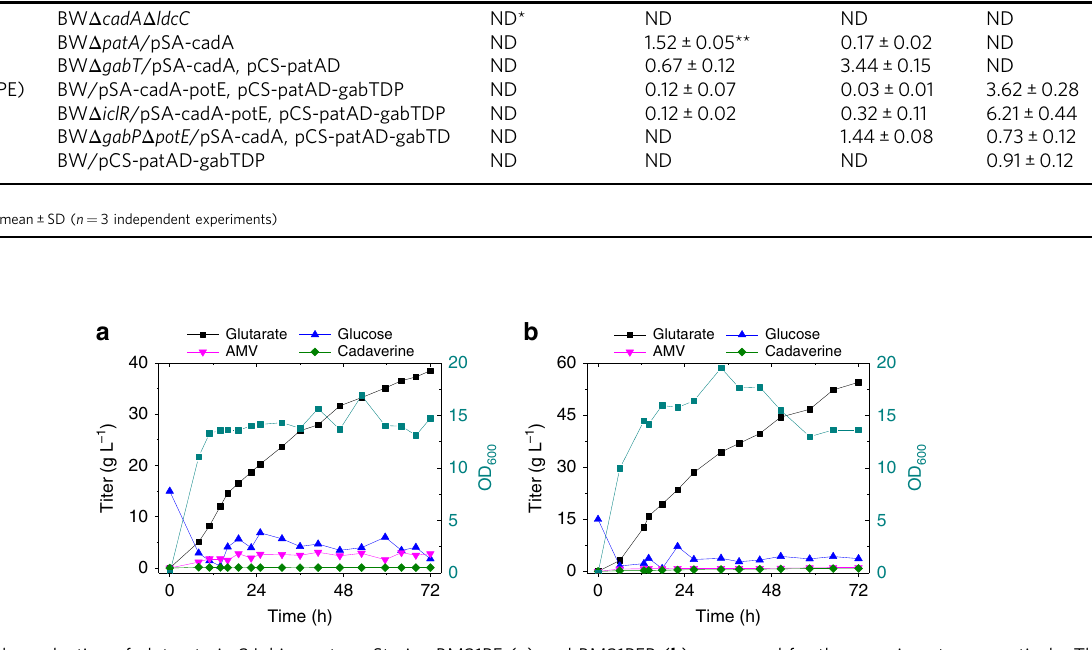
Table 1 Veri fi cation of the effect of driving forces on the pathway ef fi ciency Strains Description